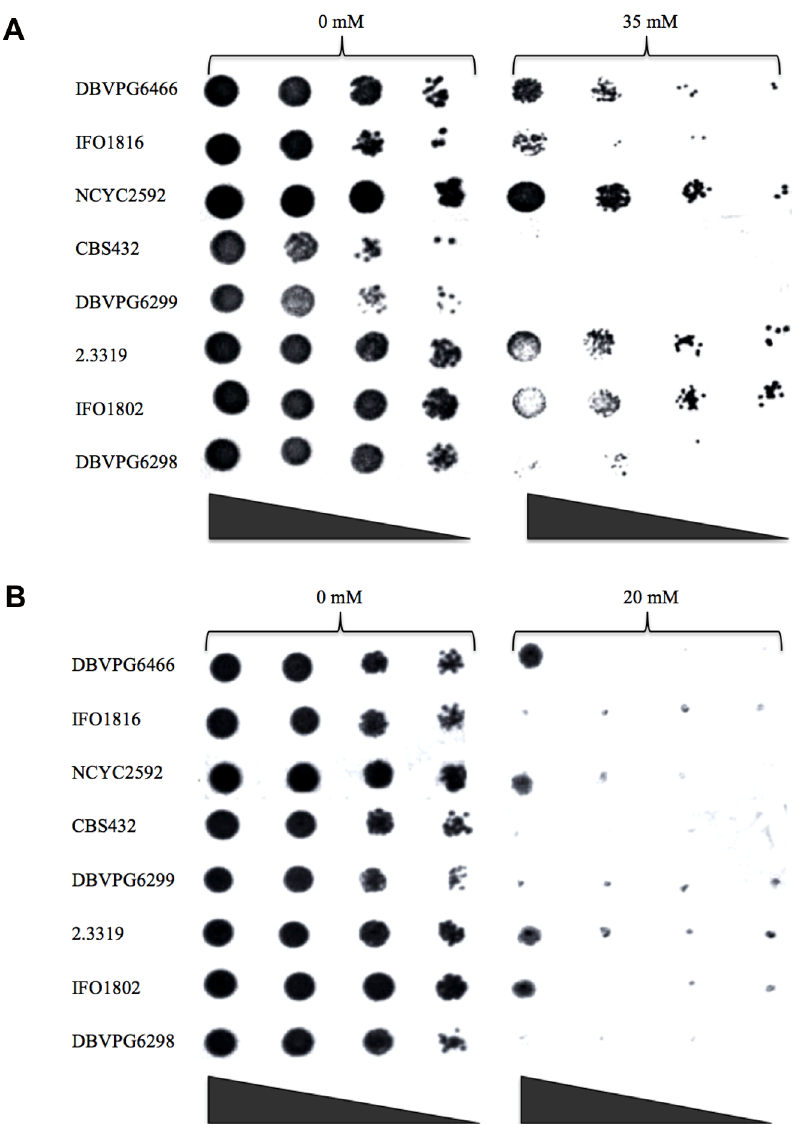
Fig 1. Tolerance to formic acid of Saccharomyces spp on solid medium using (A) YPD media with formic acid 0 and 35 mM; (B) YNB media with formic acid 0 and 20 mM. Aliquots 5 μ L from tenfold serial dilution yeast cultures (initially suspended to an OD of 1.0 with an estimated cell number of 10 7 cells/mL) were spotted on the plates. Plates were incubated at 30°C under anaerobic conditions for 48 hours. The last concentration of formic acid that cell growth can be observed was defined as tolerance